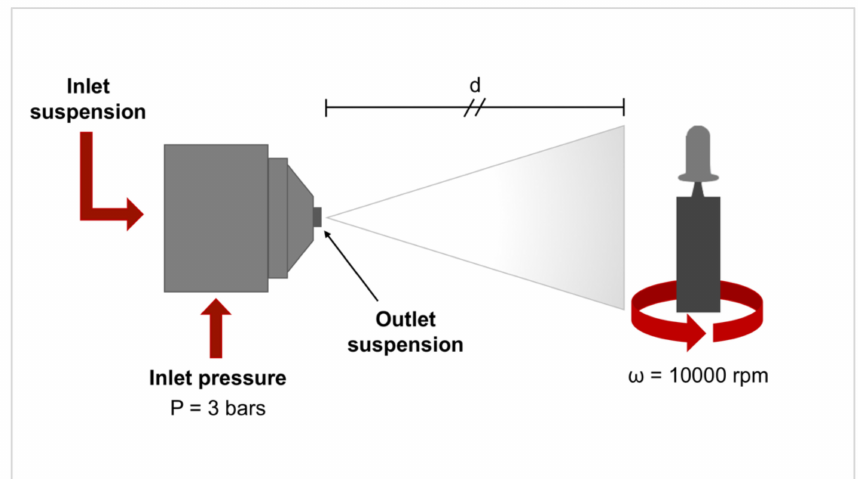
Figure 2. Schematic representation of the coating system composed of an automated airbrush and a rotatable implant holder. The customized implant, on the right, is characterized by the implant itself (in light grey) and by a coronal portion (in dark grey) for carrying the implant and which is easily detachable after the implant insertion. The main coating parameters are reported: inlet pressure P, rotating speed ω and the nozzle to implant